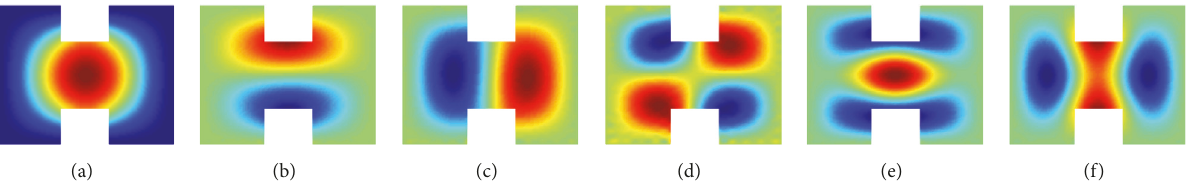
Figure 8: The first six mode shapes of the square plate with double corner cutouts. (a) The first mode; (b) the second mode; (c) the third mode; (d) the fourth mode; (e) the fifth mode; (f) the sixth mode.